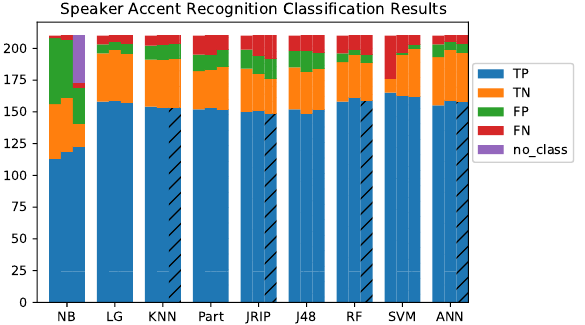
Figure 2. Graph corresponding to the Speaker Accent Recognition dataset. In blue are true positives, in orange are true negatives, in green are false positives, in red are false negatives and in purple are unclassified